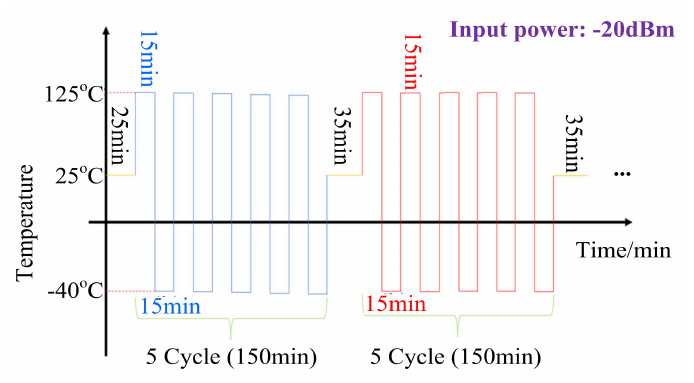
Figure 3. Schematic representation of the used thermal-cycling profile.